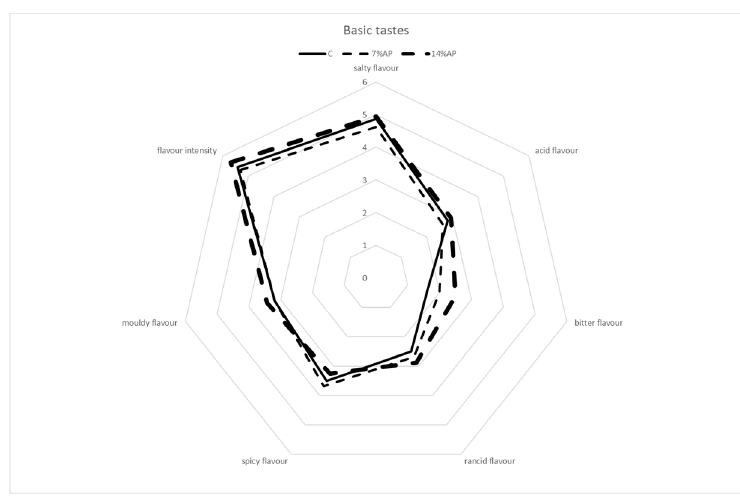
Figure 6. Sensory descriptive analysis. Basic taste.